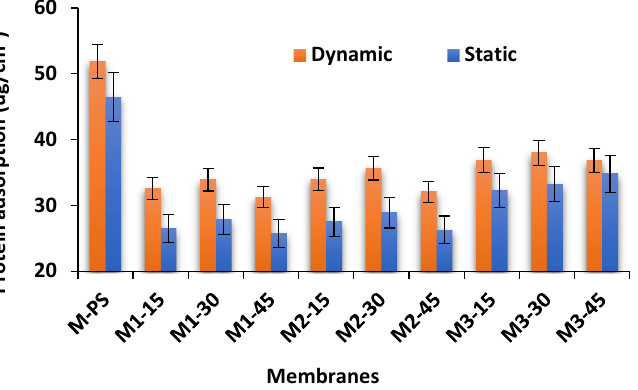
Figure 11. The static and dynamic protein adsorption results of fabricated membranes ( n = 3).